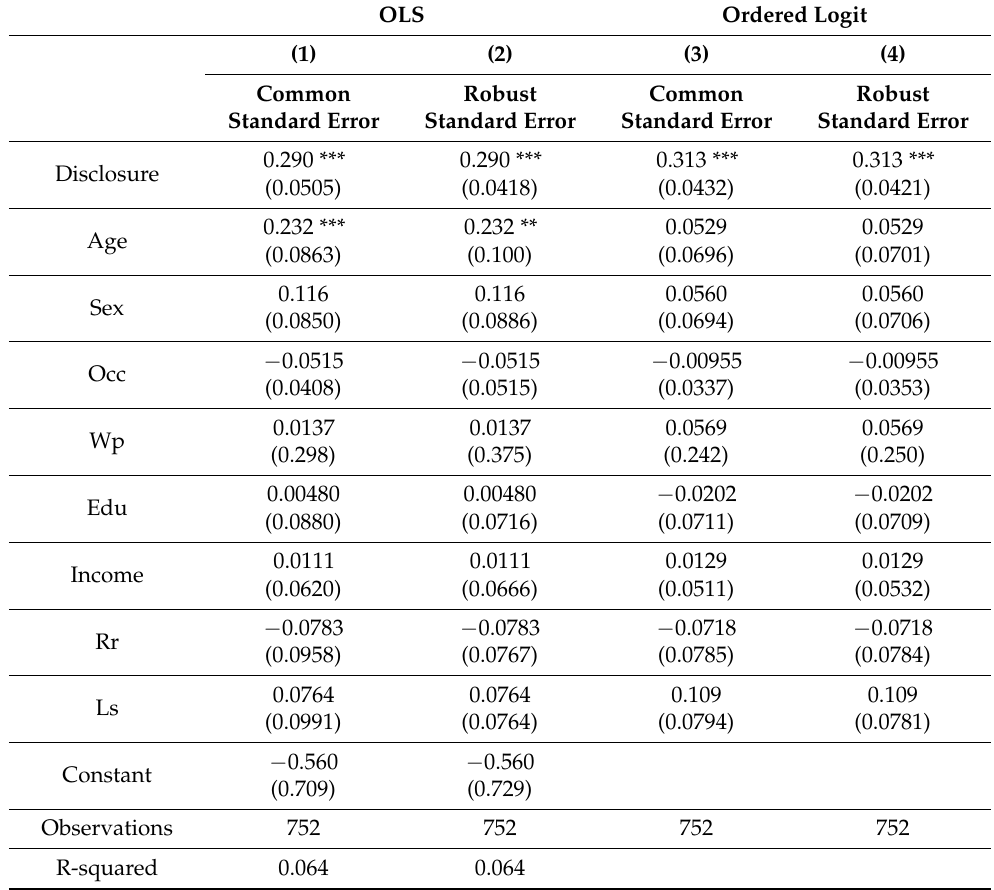
Table 2. Benchmark regression